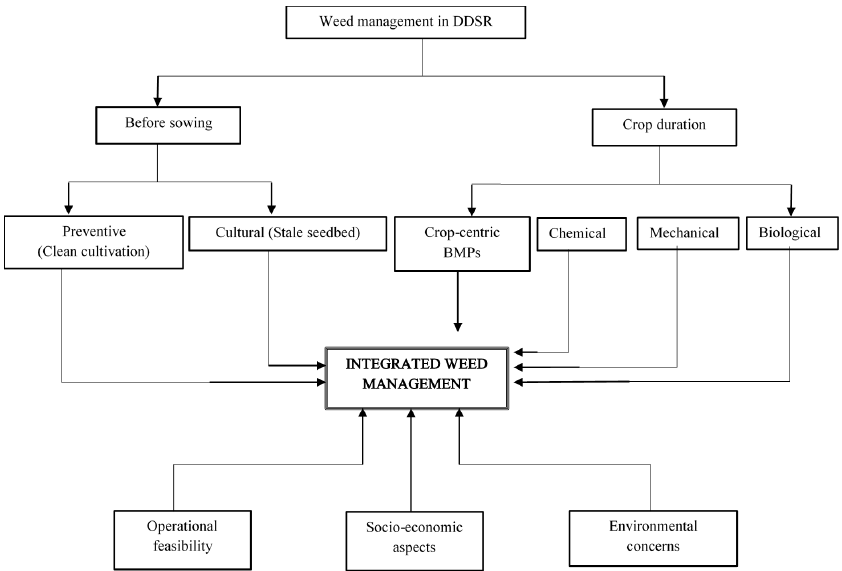
Figure 2. Integration of different management approaches for effective weed control in DDSR (Source: [53]). BMPs: best management practices.